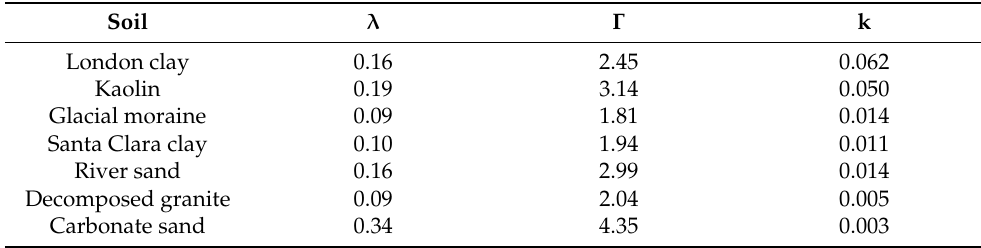
Table 3. Values of λ , Γ and k for typical soils.